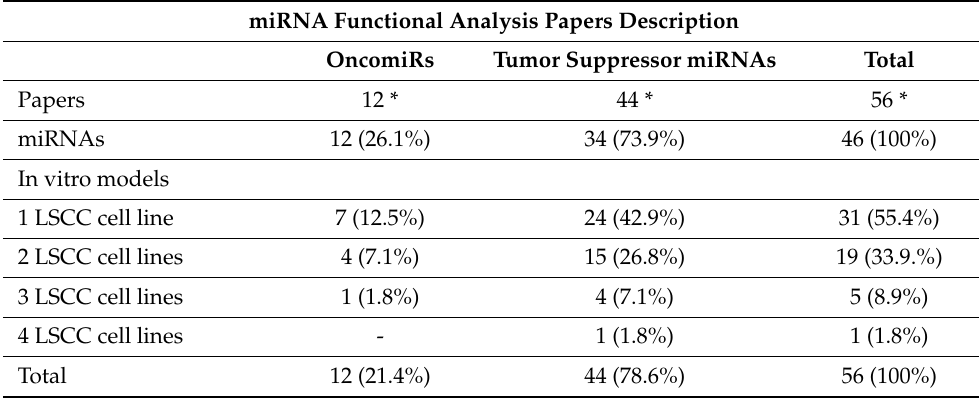
Table 6. General information about the 59 papers with miRNA functional